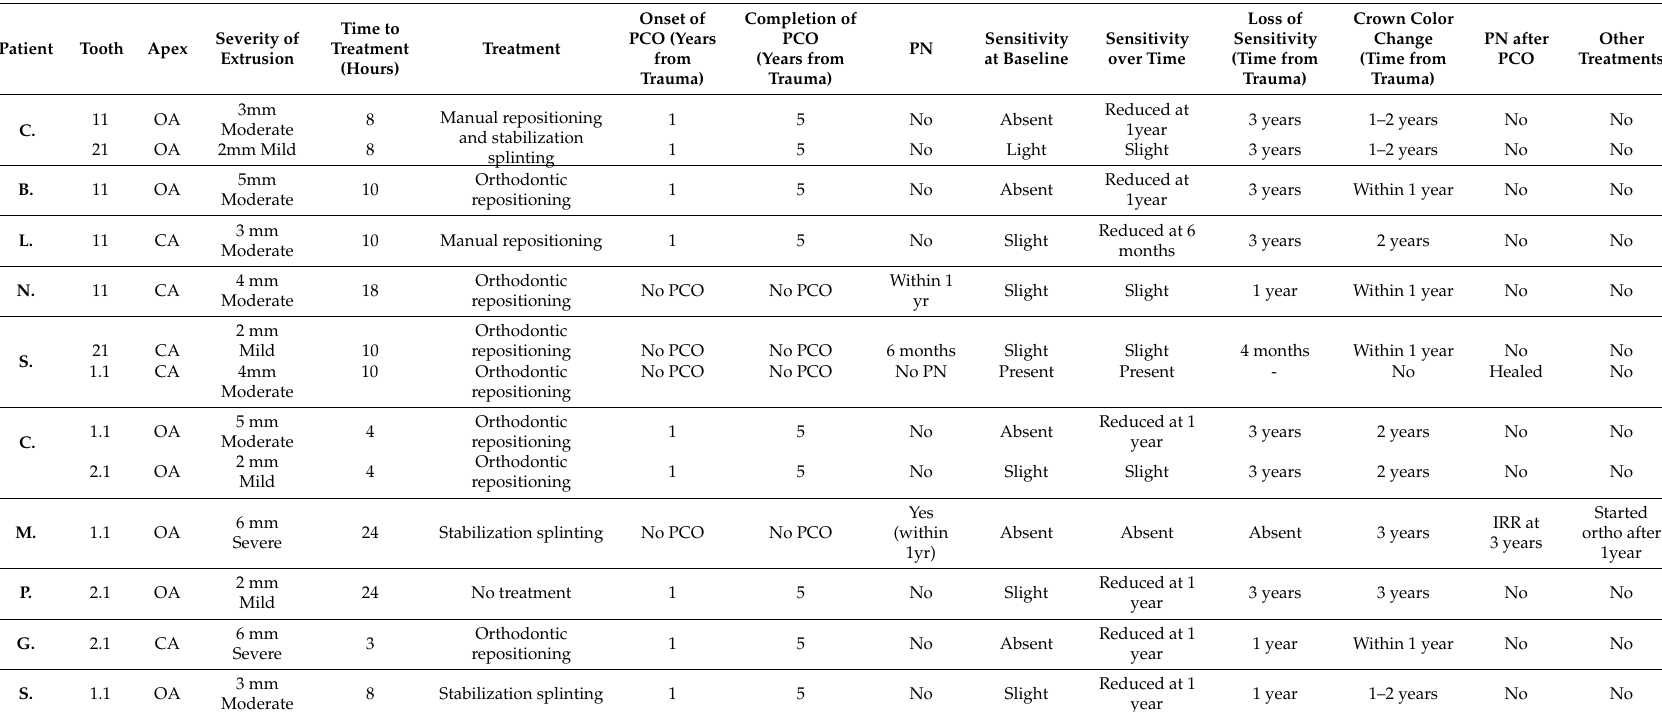
Table 3. The table shows anamnestic information, treatment performed and clinical pulp